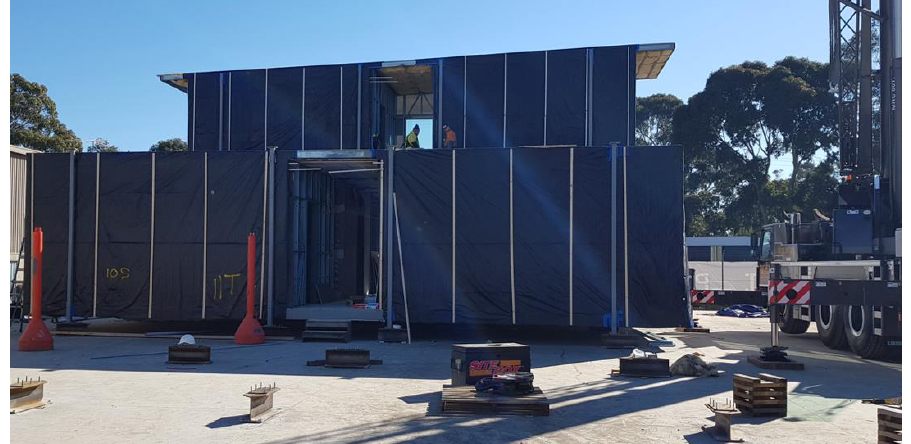
Figure 16. Example of a full-scale prototype carried out within the manufacturing facility of a prefab builder for a double storey-steel modular building to check issues in buildability and installation sequence.